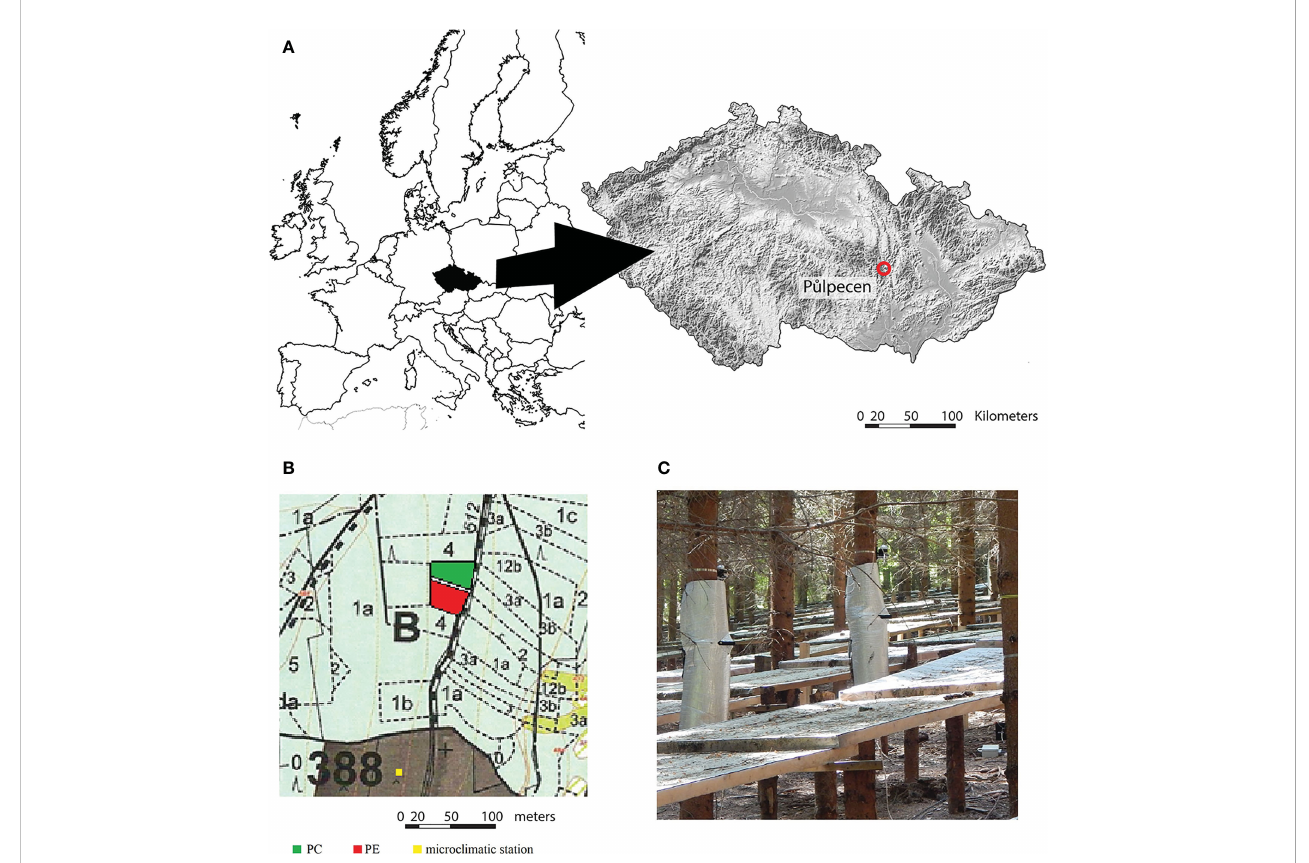
FIGURE1 Location of the study (A) , location of plots (treatments) and microclimatic station (green plot: control (PC); red plot: precipitation exclusion (PE); yellow square: microclimatic station; light green: forest area; grey: open fi eld) (B) , and the construction for rainfall exclusion in PE (C)